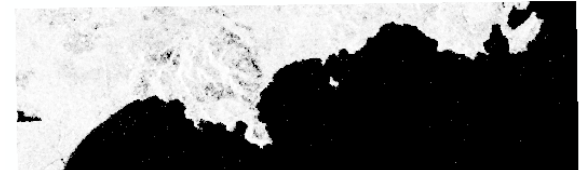
Figure 4. Fuzzy membership of the land, Dark is low, bright is high membership of the land class.